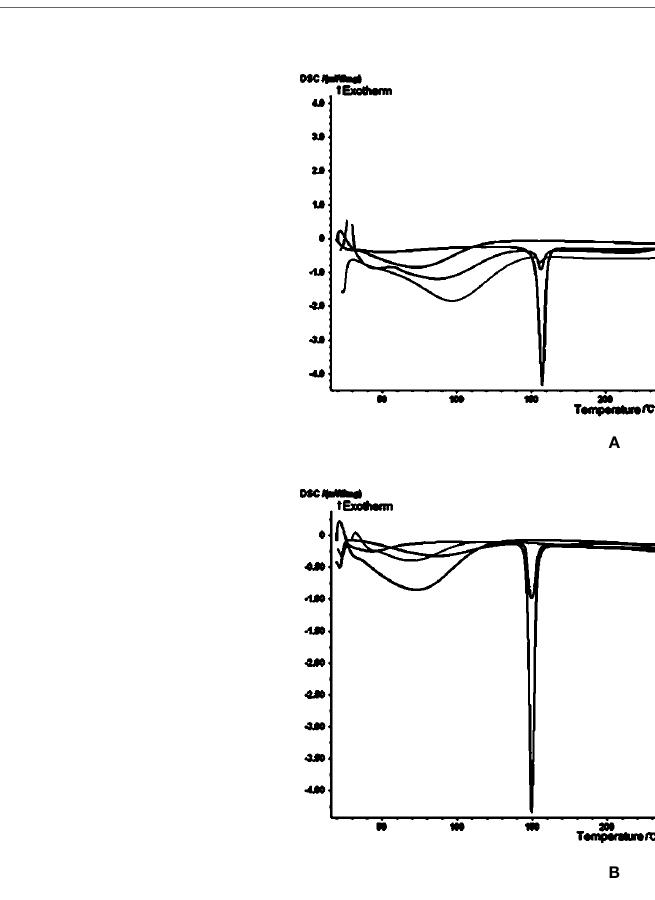
FIGURE 7 | Images from the differential scanning calorimetry (DSC) analysis. Green line: hydroxypropyl- b -cyclodextrin (HP- b -CD); blue line: styryllactone only; brown line: physical mixture; pink line: complexes of HP- b -CD with (A) cheliensisin A and (B)